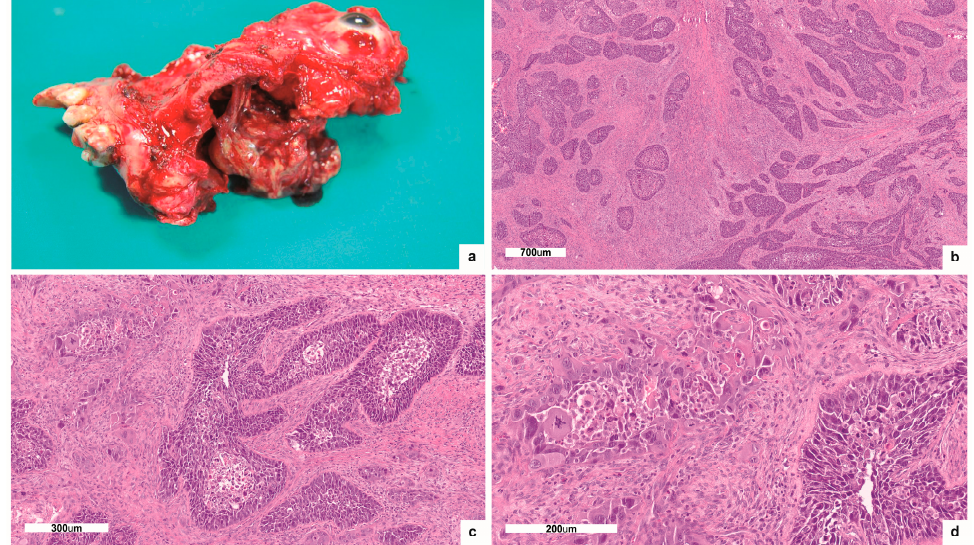
Figure 1. Gross examination and H and E stain: ( a ) Gross examination of left hemimaxillectomy with turbinectomy and exenteratio orbitae revealed a nodular lesion macroscopically occupying the maxillary sinus and infiltrating the orbital floor; ( b , c , d ) H-and-E-stained tissue sections demonstrated a poorly differentiated, infiltrating carcinoma (b:50×; c:100×; d:200×).